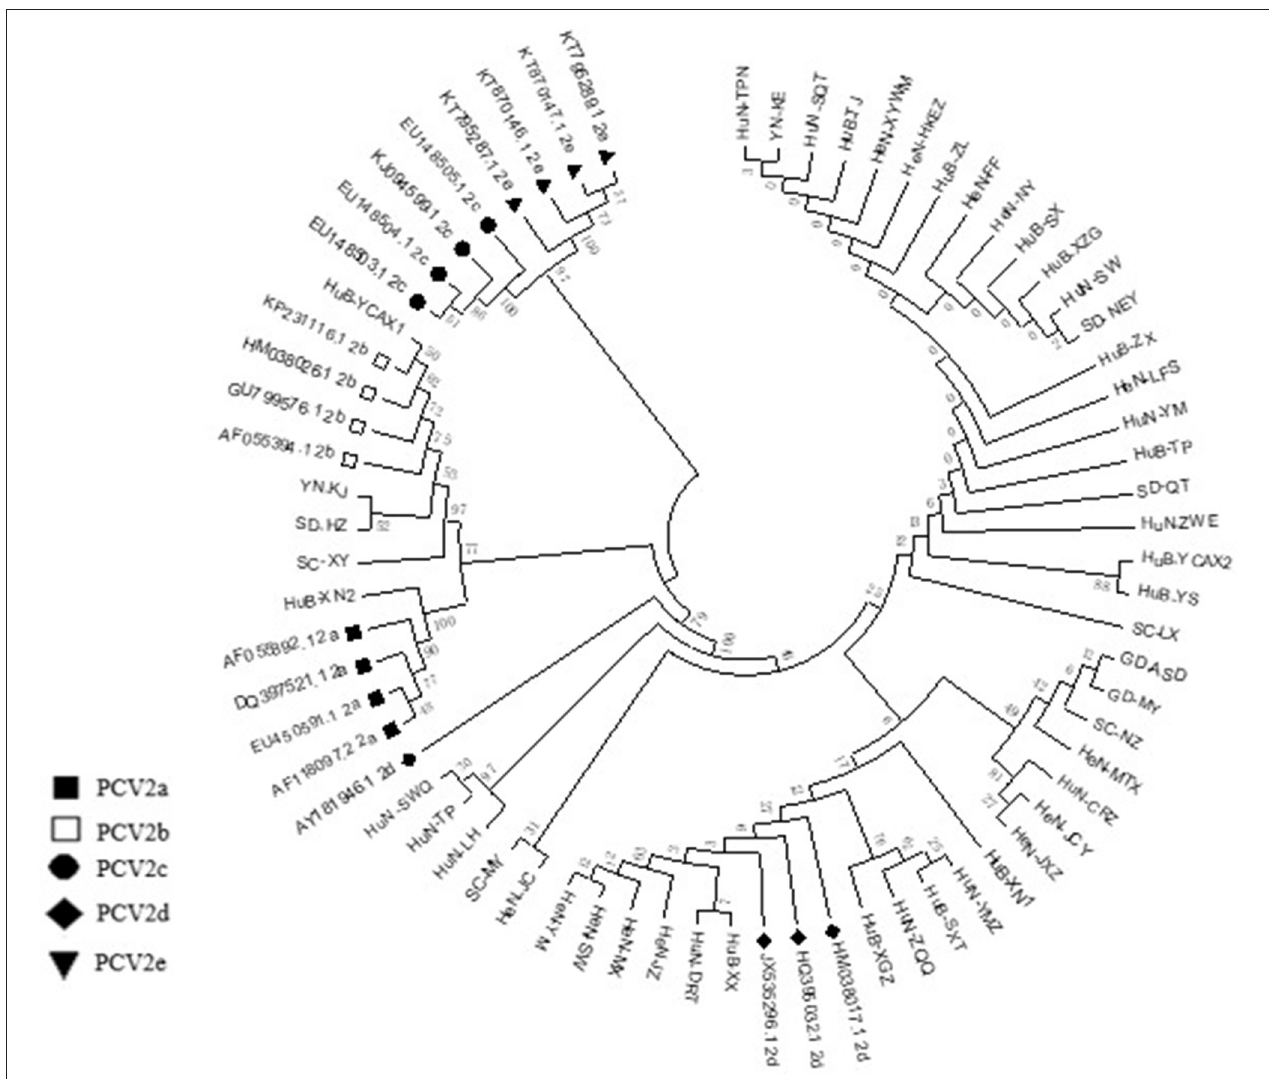
FIGURE 4 | Phylogenetic tree based on 82 PCV2 nucleotide sequences, including the 62 samples obtained in this study (not marked) and 20 strains of the different genotypes available from GenBank (PCV2a to PCV2e) (marked). The phylogenetic tree was constructed by the neighbor-joining method using the maximum composite likelihood model with MEGA v6